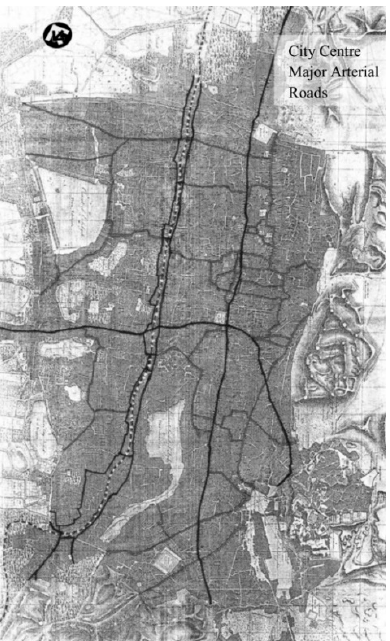
Fig. 1. The City major arterial roads, on the Napoleon map, the author.